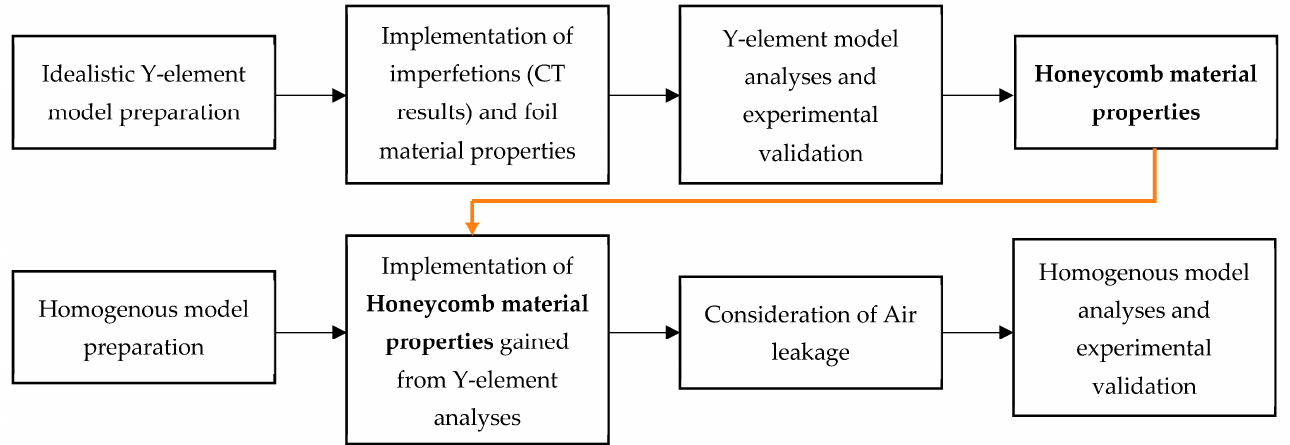
Figure 2. Research methodology scheme.